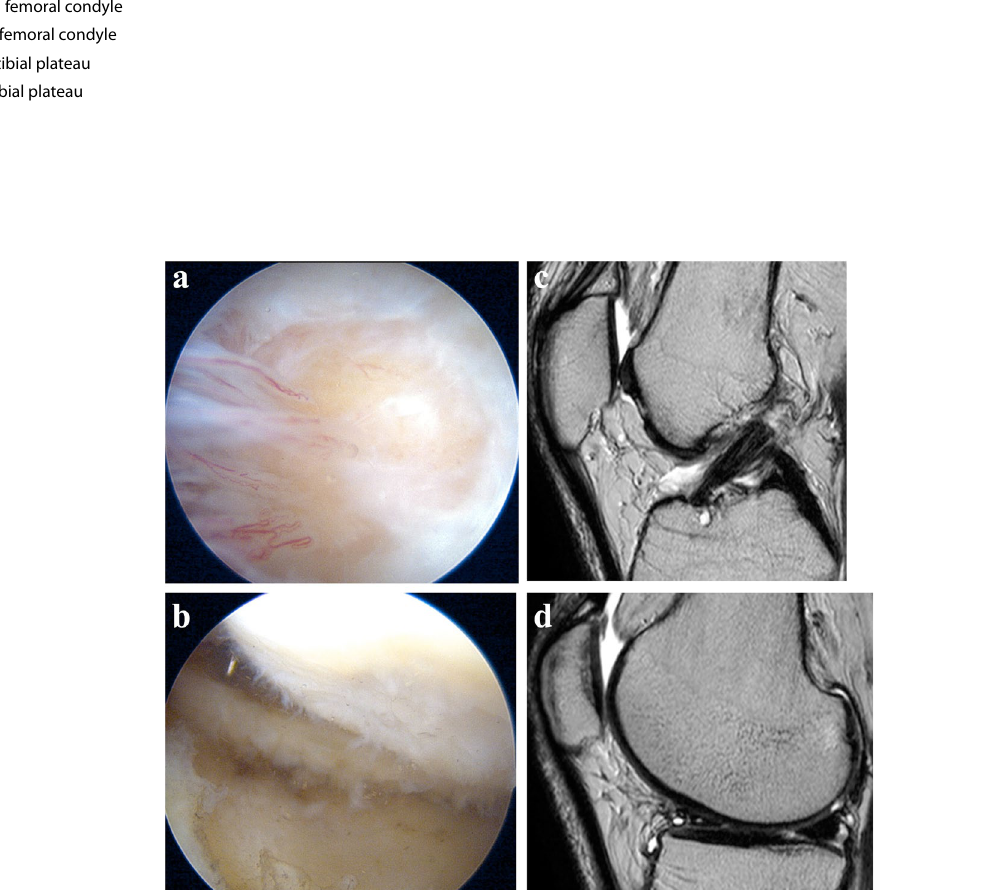
MFC Medial femoral condyle